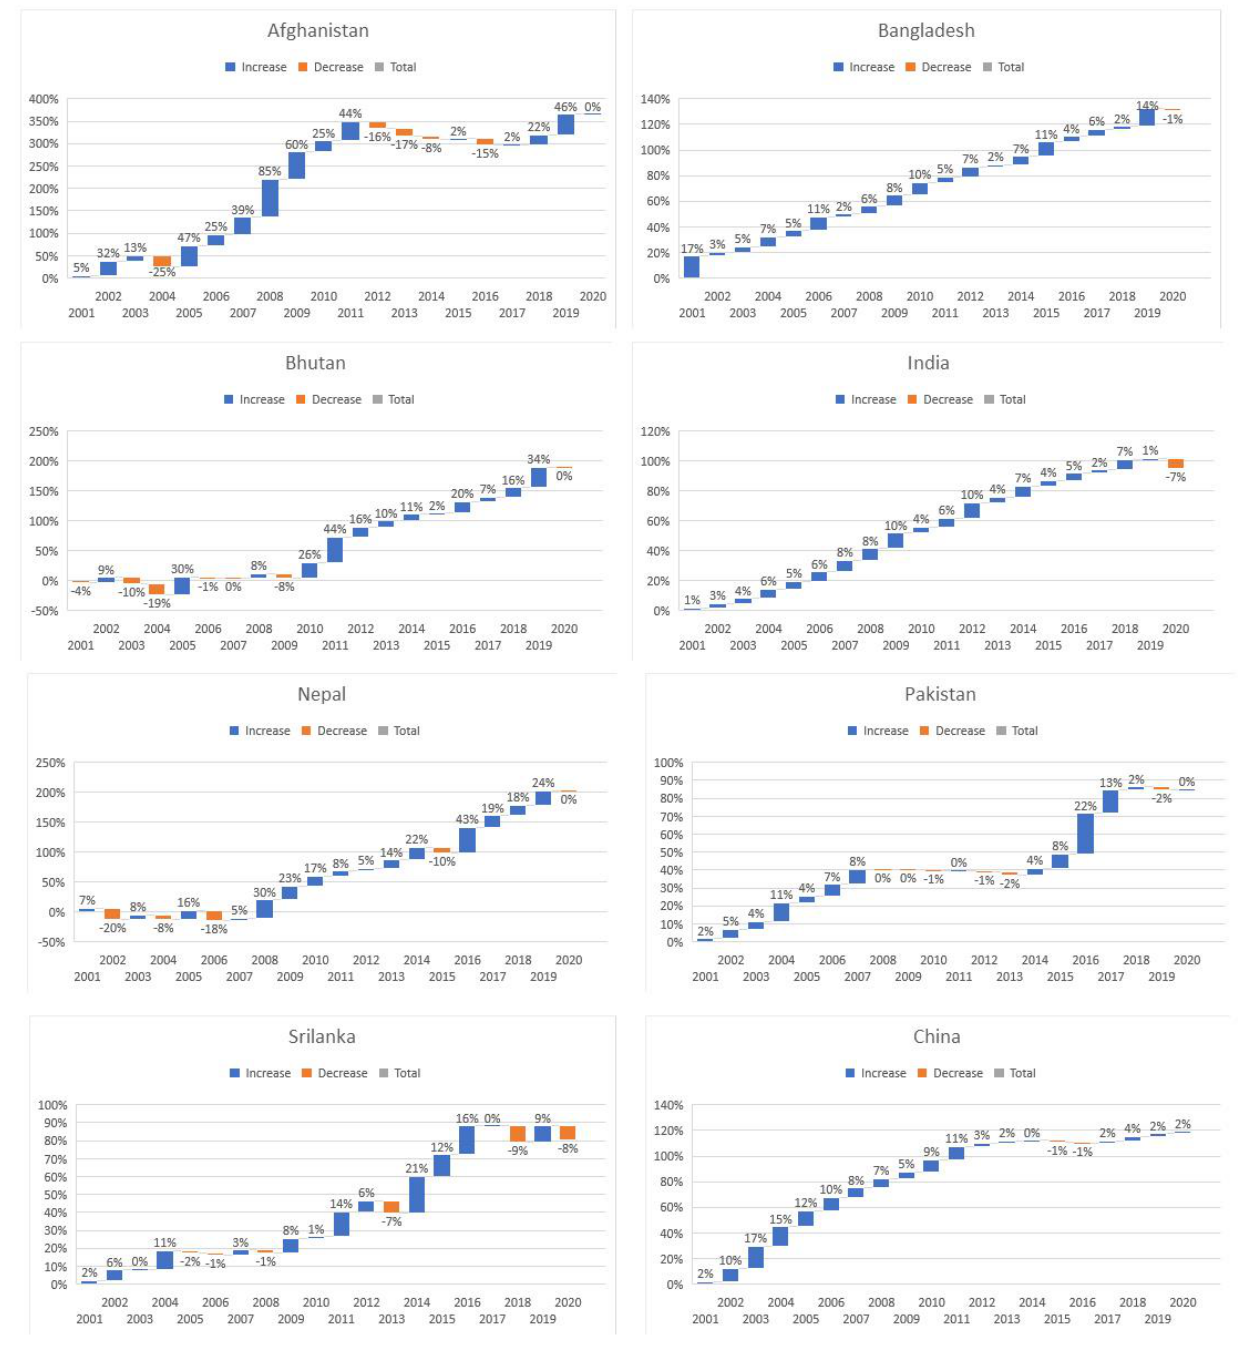
Figure 4. Change in CO 2 emission patterns in South Asia in the last 20